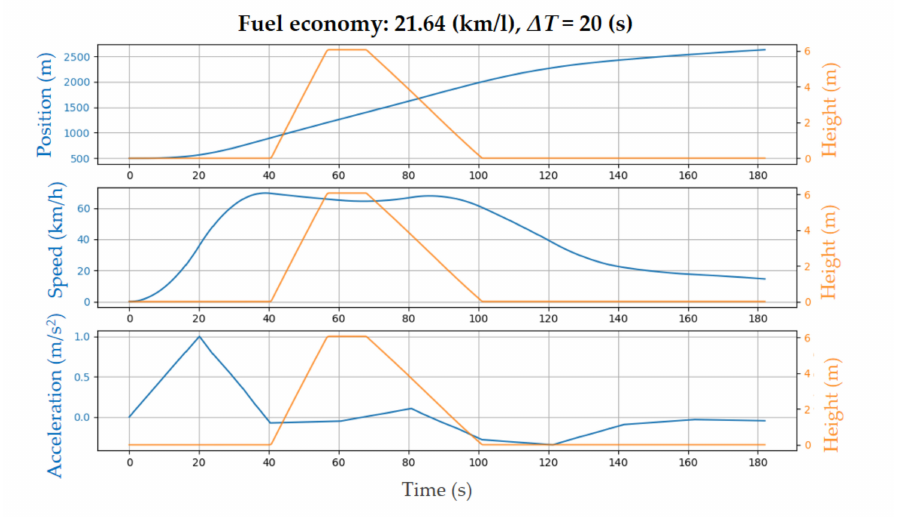
Figure 11. The best trip in the three sets. The velocity generator found the strategy to accelerate up to 70 km / h until the uphill starts and slowly decelerates except for slight acceleration that is given during the downhill.